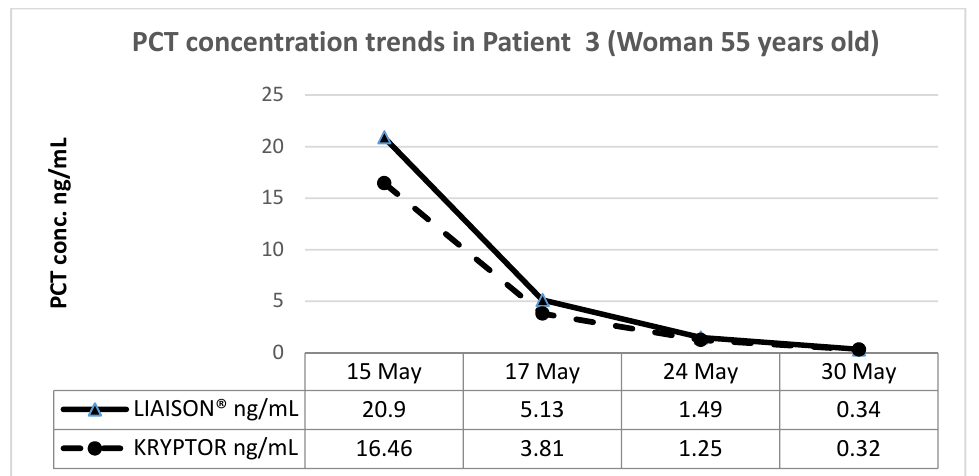
Figure 5. Patient 3 (Medical oncology, woman 55 years old).